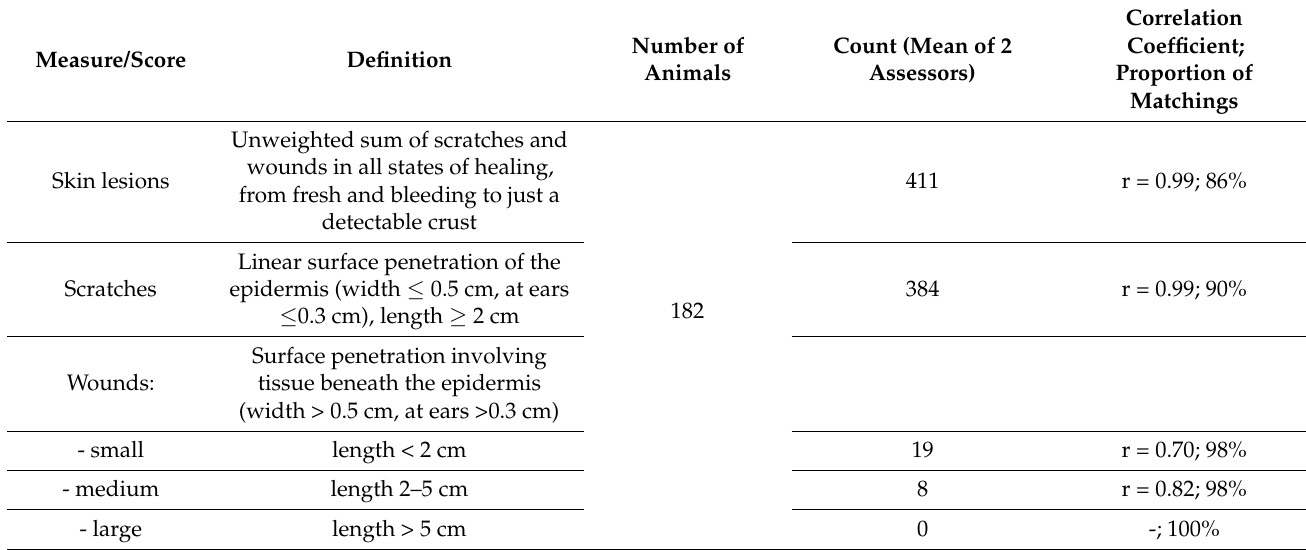
Table 3. Definitions of the scores regarding skin lesions (modified from Welfare Quality ® , 2009) and results of inter-assessor reliability testing between two assessors (Pearson correlation coefficient r and proportion of matchings; n = 182 pigs).